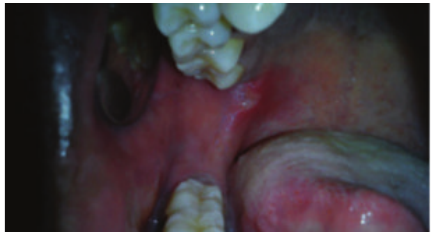
Figure 4: Ulcer at the retromolar region of the mouth.